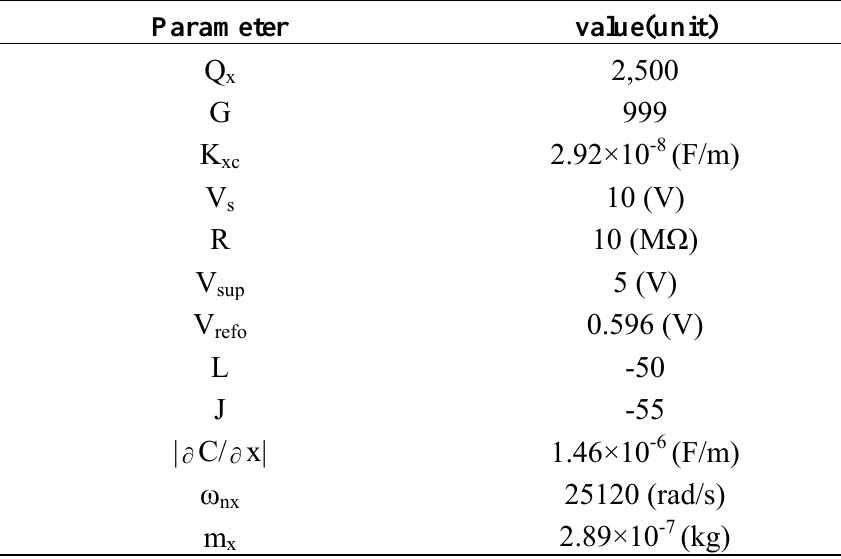
Table 1. The value of simulation